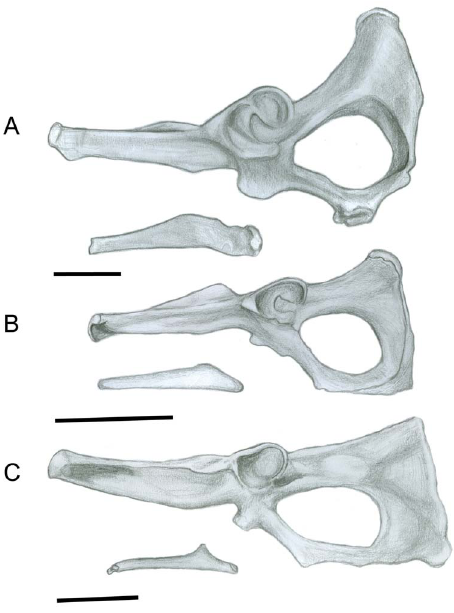
Figure 3. Pelvis. (A) Simosthenurus occidentalis (SAM: P17358). (B) Dendrolagus dorianus (SAM: M9190) (C). Macropus robustus